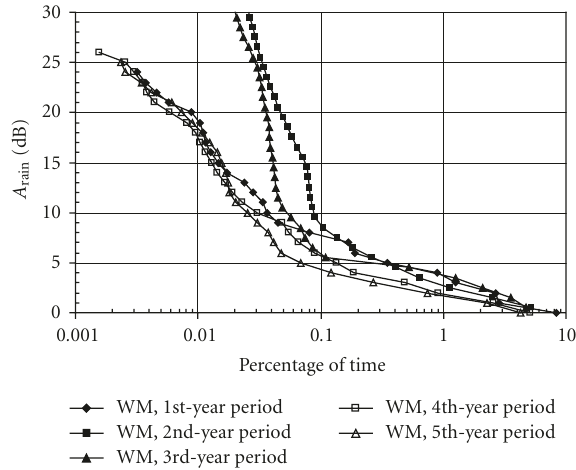
Figure 6: CDs of rain attenuation for WM of individual 1-year periods.